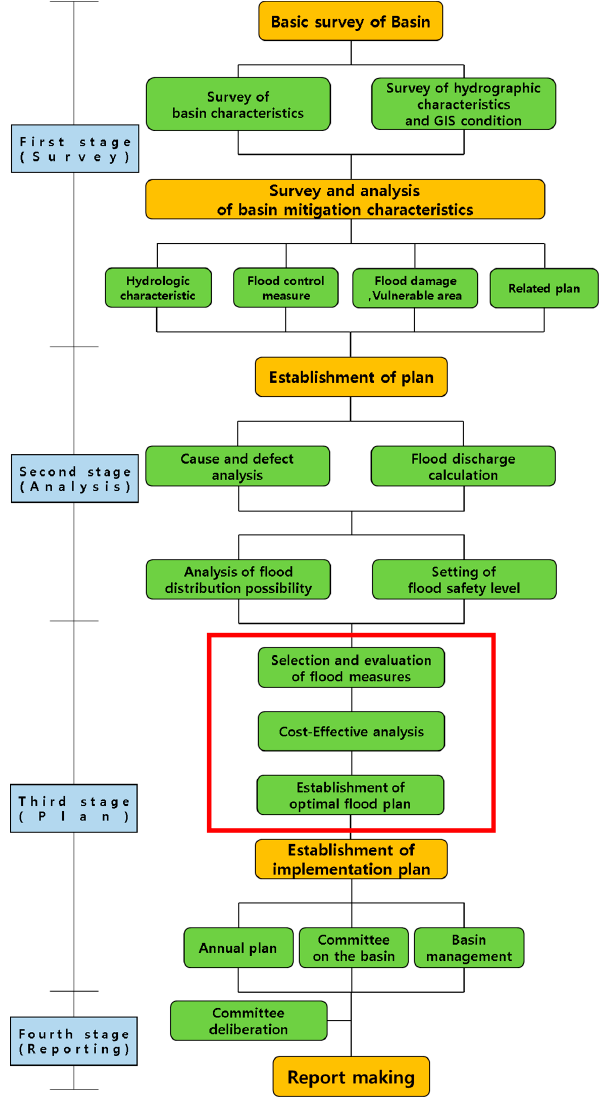
Figure 1. Planning process of the Comprehensive Flood Prevention Plan for River Basin (CFPPB)